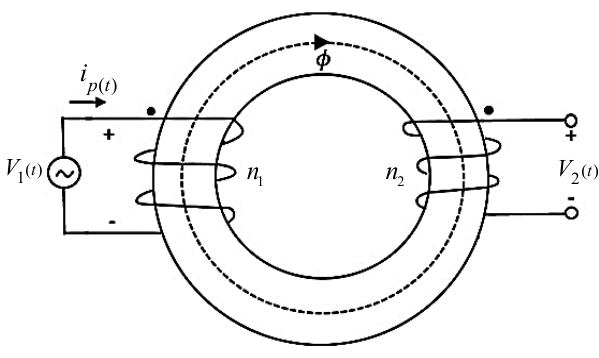
Figure 5. Inductors with the same number of turns in the primary and secondary windings.